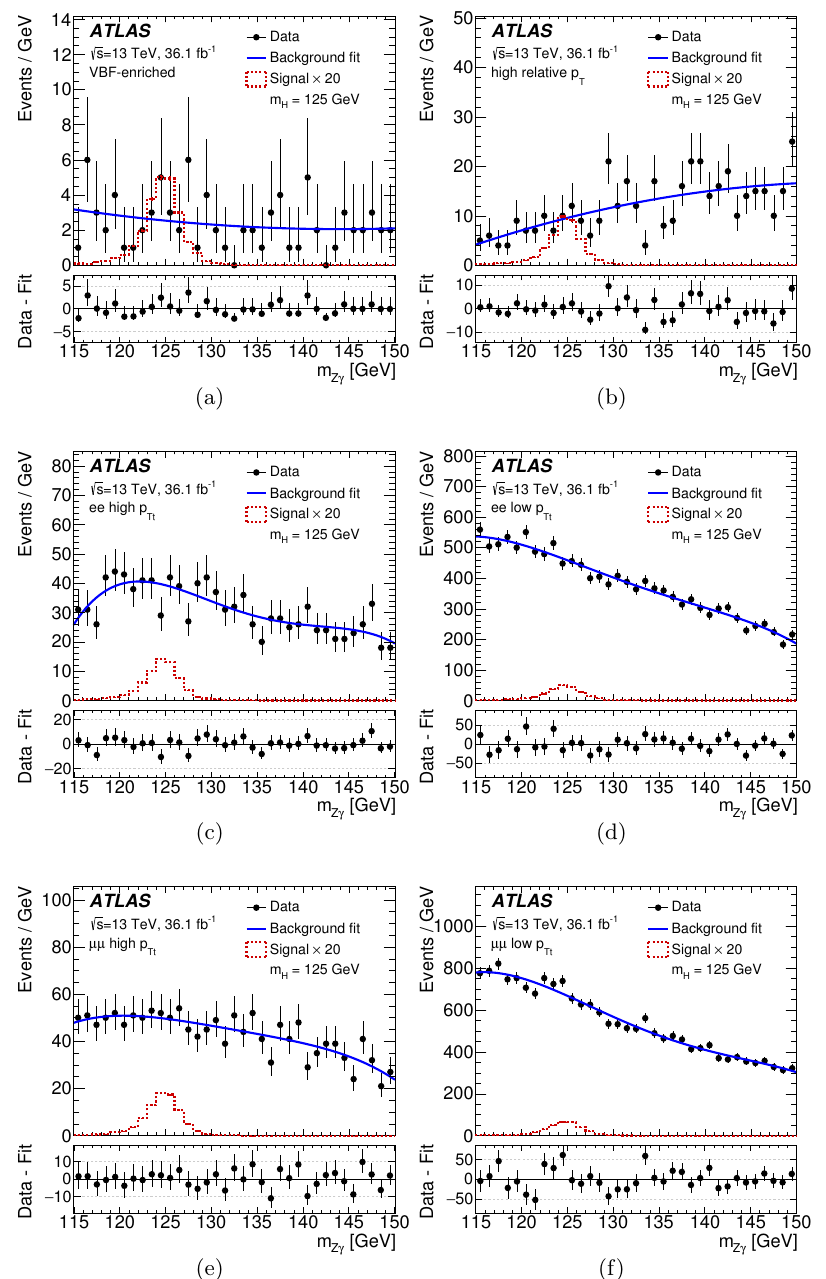
Figure 5 . The invariant Z(cid:13) mass ( m Z(cid:13) ) distributions of events satisfying the H ! Z(cid:13) selection in data for the six event categories: (a) VBF-enriched, (b) high p (cid:13) , (c) ee high p T t , (d) ee low p T t , (e) T (cid:22)(cid:22) high p T t , and (f) (cid:22)(cid:22) low p T t . The points represent the data and the statistical uncertainty. The solid lines show the background-only (cid:12)ts to the data, performed independently in each category. The dashed histogram corresponds to the expected signal for a SM Higgs boson with m H = 125 GeV decaying to Z(cid:13) with a rate 20 times the SM prediction. The bottom part of the (cid:12)gures shows the residuals of the data with respect to the background-only